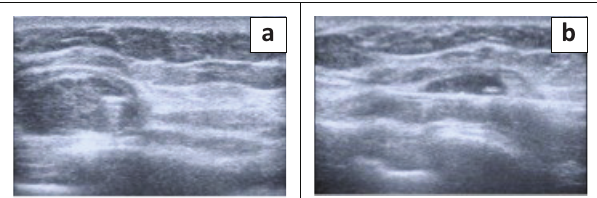
FIGU RE 5: Post-surgical, axial (a) and sagittal (b) views of the left breast on ultrasound demonstrating the largest hypoechoic lesions at the inferior- lateral aspect of the scar. This lesion was not separable from the underlying pectoralis